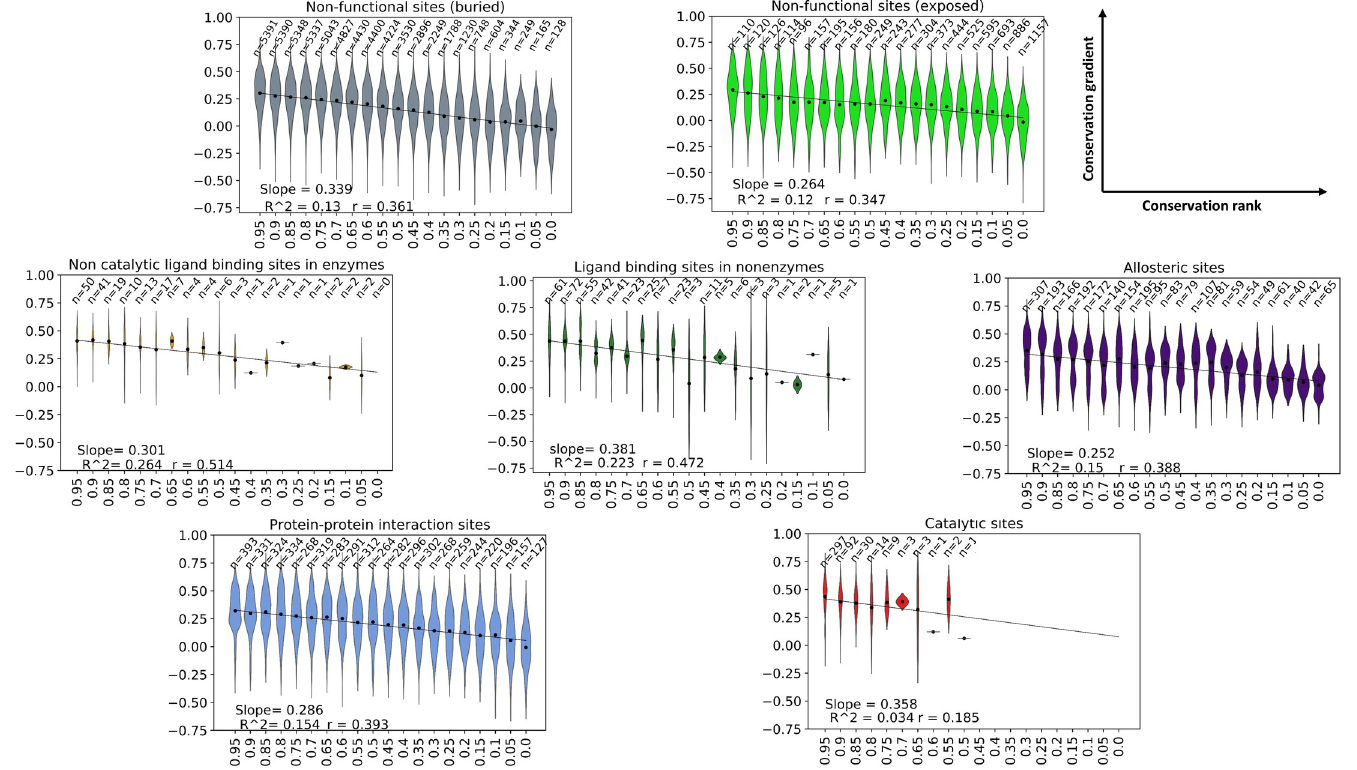
Fig 2. Residues in functional and structural sites exhibit linear correlation between conservation and conservation gradient. Violin plots of conservation gradient of residues as a function of their conservation rank within the protein along with the linear fit calculated over all residues in different types of structural and functional